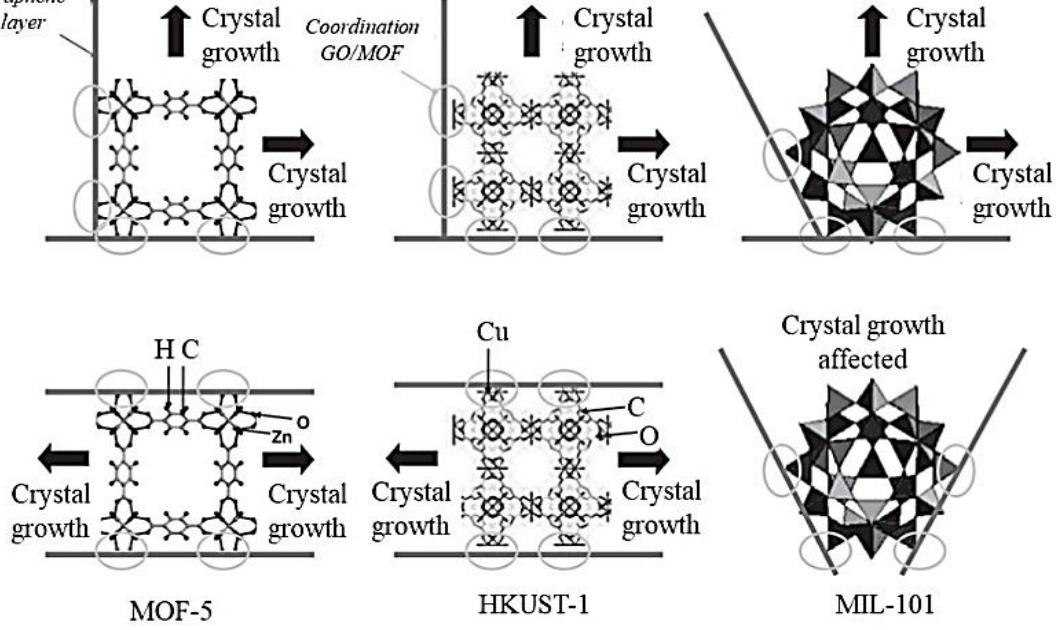
Figure 4. Schematic comparison of the coordination between GO carbon layers to the MOF units for different types of MOF networks: MOF − 5, HKUTS − 1, and MIL − 100. Reproduced with permission from [45]. Copyright 2011, Wiley.